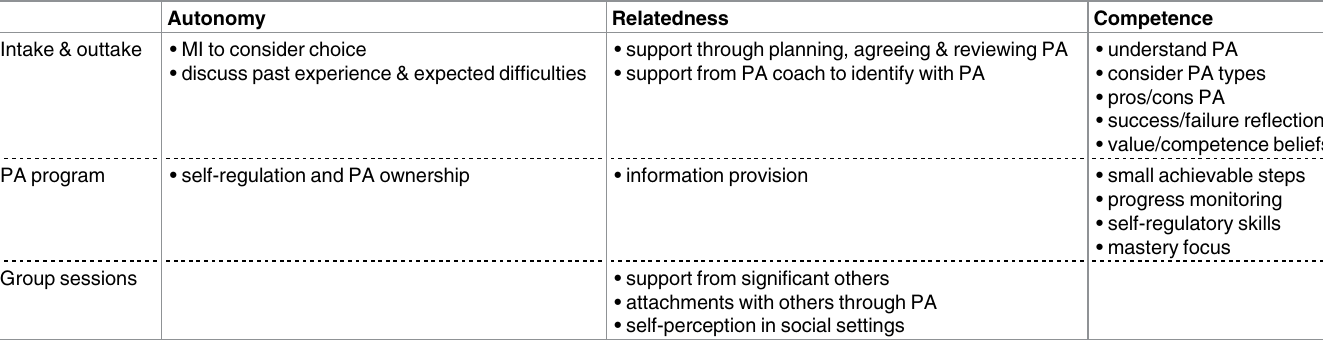
Table 1. Links between key intervention elements and need support